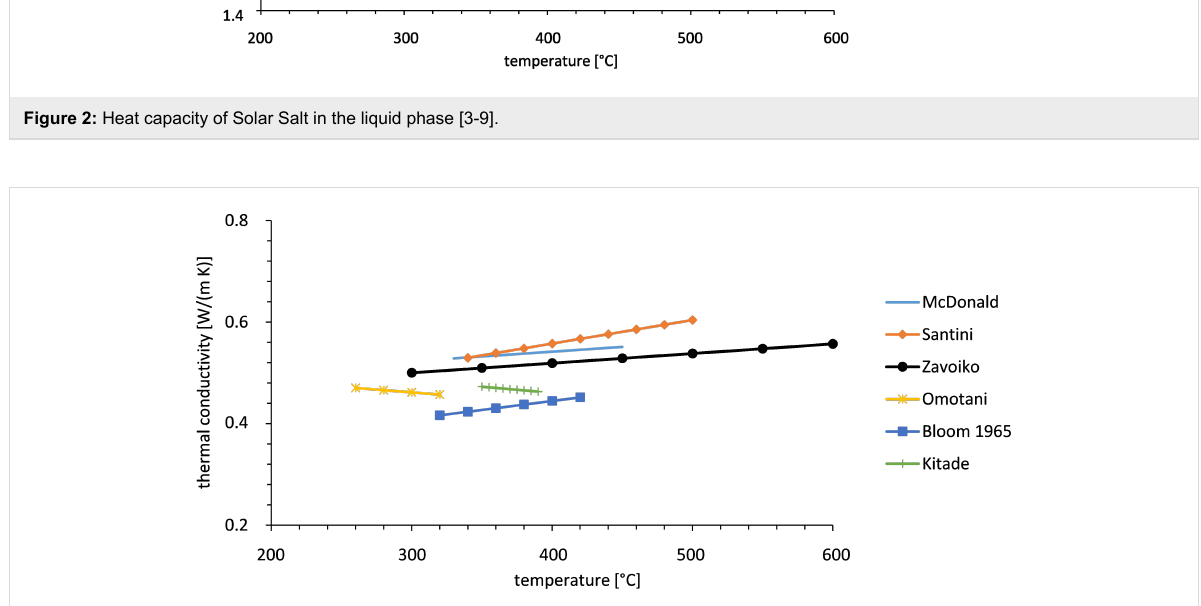
Figure 3: Thermal conductivity of Solar Salt reported by several groups